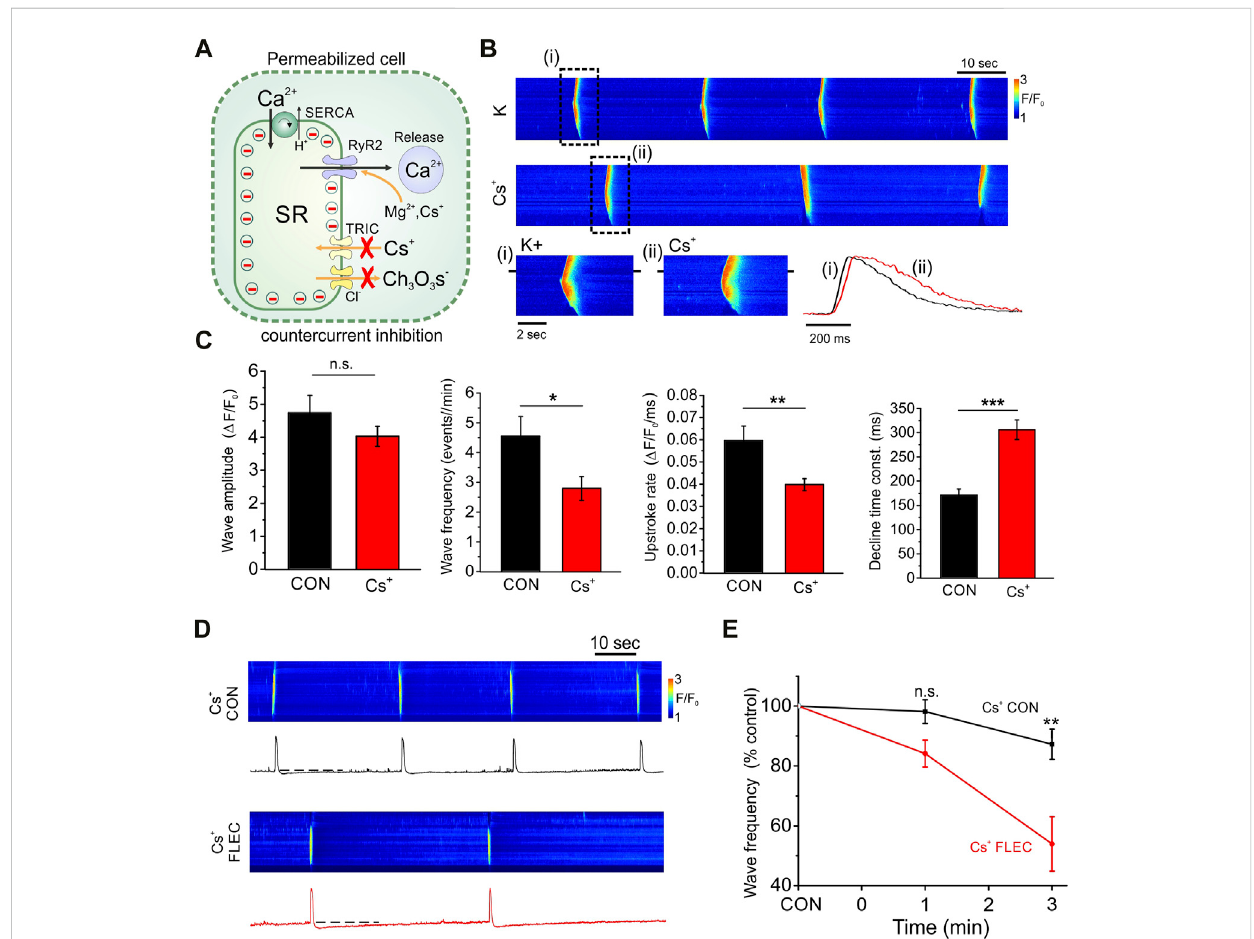
FIGURE 3 Effects of countercurrent inhibition on SR Ca 2+ regulation and the action of fl ecainide. (A) , Diagram shows permeabilized cell in which counter- currents during SRCa 2+ release are inhibited bysubstitutionofK + and Cl − with Cs + andCh 3 O 3 S − ions, which have alow permeability through SRK + (TRIC) channels and Cl − channels respectively. Counter-current movement (including Cs + ) can still occur via RyR2 and SERCA exhibits counter transport of H + . Partial counter-current inhibition would be expected to increase transient SR polarization during Ca 2+ in fl ux or ef fl ux, thereby opposing Ca 2+ movements across the SR membrane. (B) , Line scan images and corresponding line pro fi les from the same cell before (i) and after (ii) counter-current inhibition, showing a decrease in Ca 2+ wave frequency and slowing of both Ca 2+ release and reuptake. (C) , Cumulative data showing effects of counter- current inhibition on Ca 2+ wave amplitude, frequency, upstroke rate and the time constant of the descending phase. (D) , Line scan images and correspondinglinepro fi lesfromthesamecellbeforeandafterintroductionof fl ecainideduringconstantcounter-currentinhibition. (E) ,Cumulativedata showing time dependenteffects of fl ecainide on Ca 2+ wave frequency during counter-currentinhibition. Cs + control (Cs + CON)n = 13 (5), Cs + fl ecainide (Cs + FLEC) n = 13 (5), ** p <